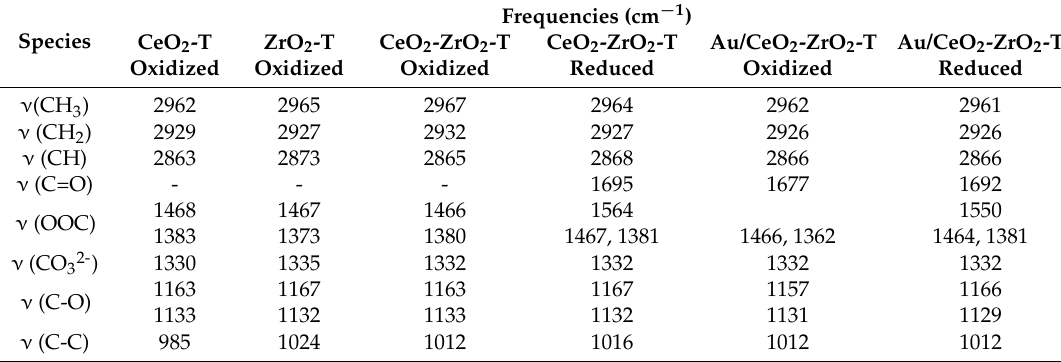
Table 5. IR vibrational wavenumbers from the adsorption of 2-propanol on various catalysts.